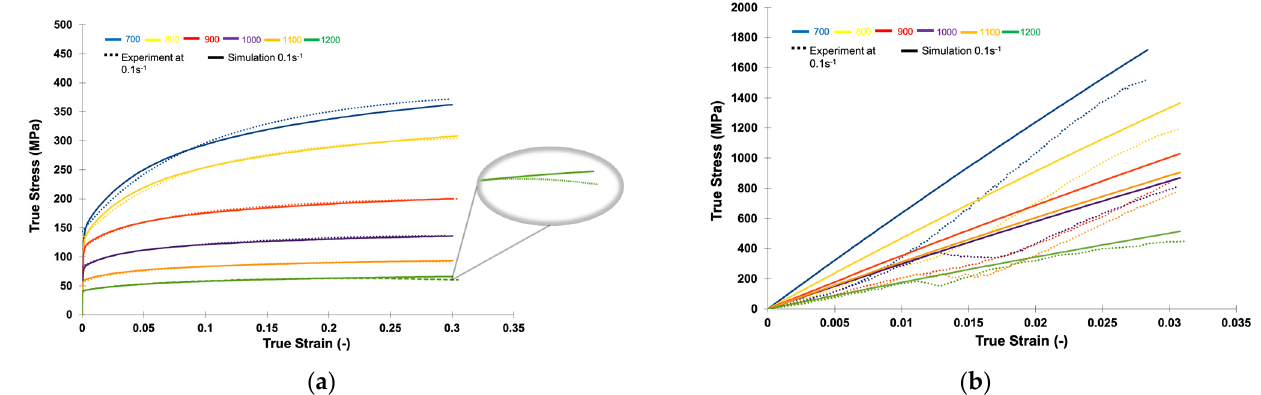
Figure 6. ( a ) Comparison of the experimental and simulation results for ( a ) austenite showing dynamic softening at 1200 °C, ( b ) zirconia at 700–1200 °C with a strain rate of 0.1 s –1 .